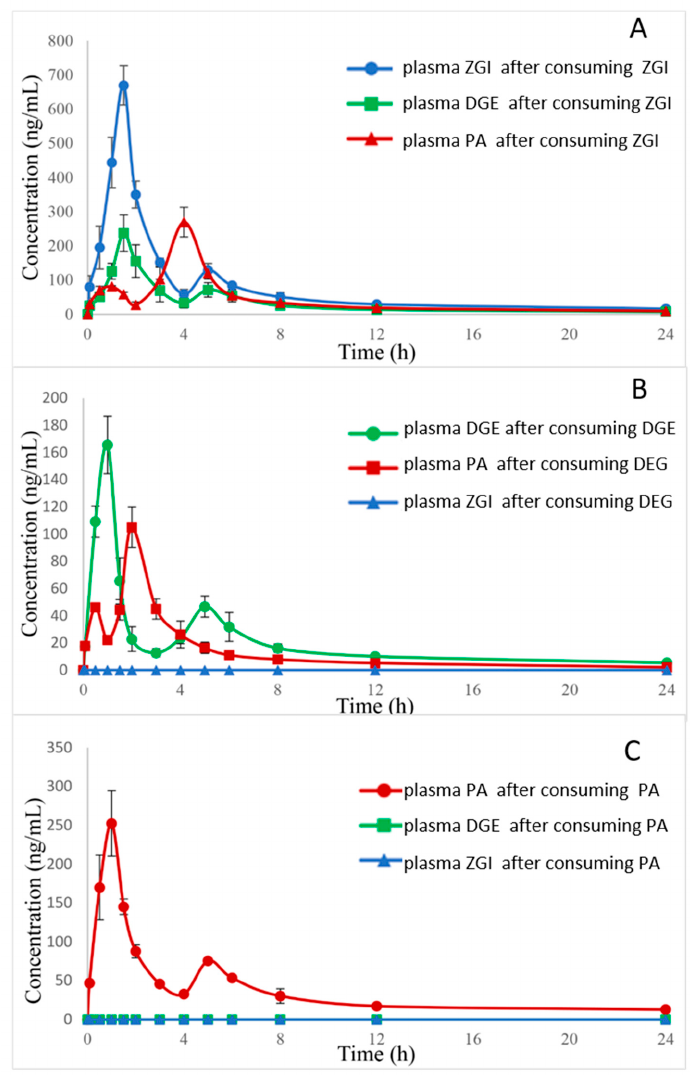
Figure 4. ( A ): Mean plasma concentration–time curve of the three compounds in rats after oral administration of ZGI; ( B ): Mean plasma concentration–time curve of the three compounds in rats after oral administration of DGE; ( C ): Mean plasma concentration–time curve of the three compounds in rats after oral administration of PA.